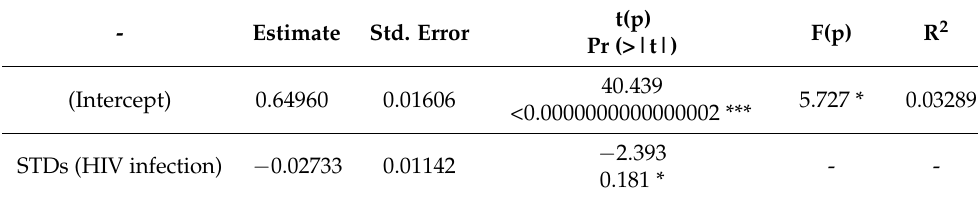
Table 16. Regression between STDs (HIV infection) and education.